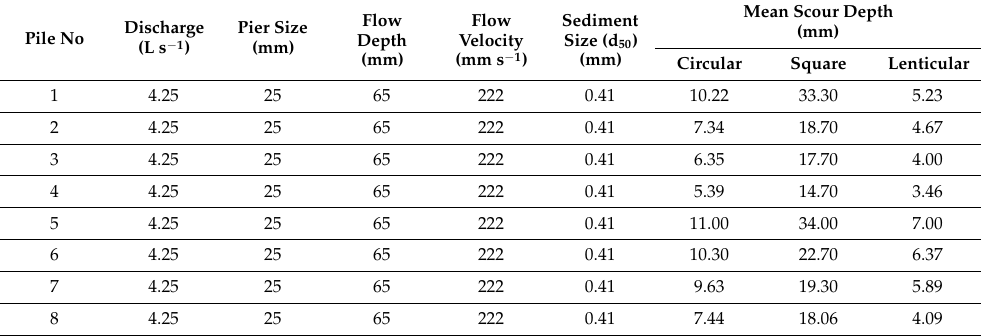
Table A2. Scouring depth at position